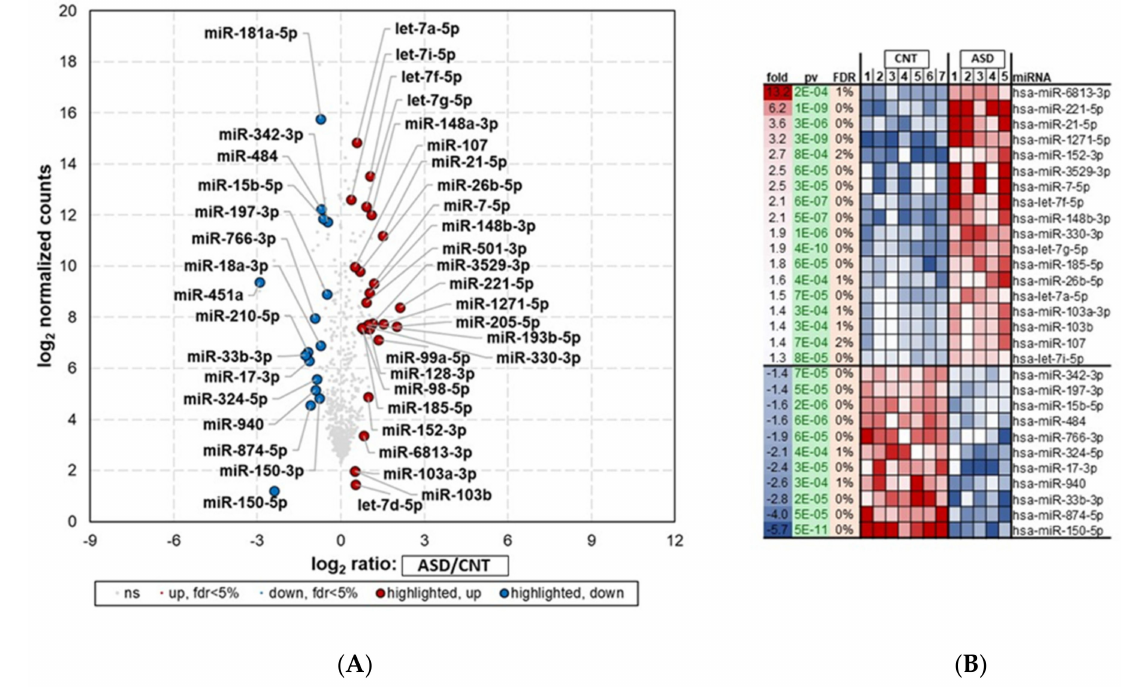
Figure 3. miRNA-seq analysis showing differential expression of top 29 miRNAs in LCLs groups— ASD ( n = 5) and CNT ( n = 7)—with FDR < 5%. Samples with poor alignment rates which were dropped from differential expression analysis, included 5 from ASD group. ( A ) Volcano plot of differentially expressed miRNAs in ASD and CNT LCLs. ( B ) Heatmap of differentially expressed miRNAs in ASD and CNT LCLs. ASD = Autism, CNT = Control, Fold = Fold change„ pv = p -value, and miRNA. Red dots are upregulated, blue dots are downregulated, and grey dots indicate no change; FDR = false discovery